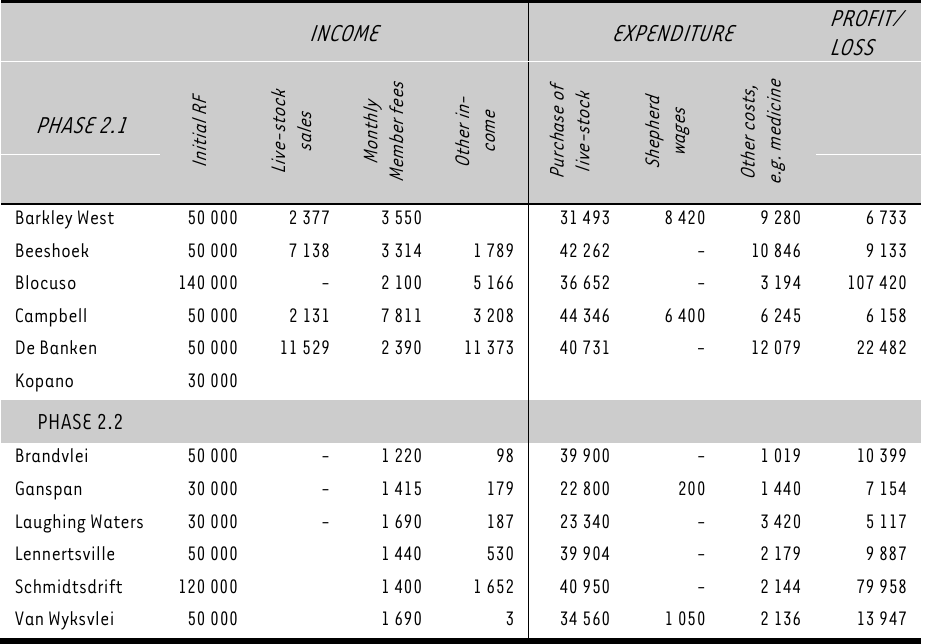
TABLE 3: LB financial situation at June 2006 (Rand) INCOME EXPENDITURE